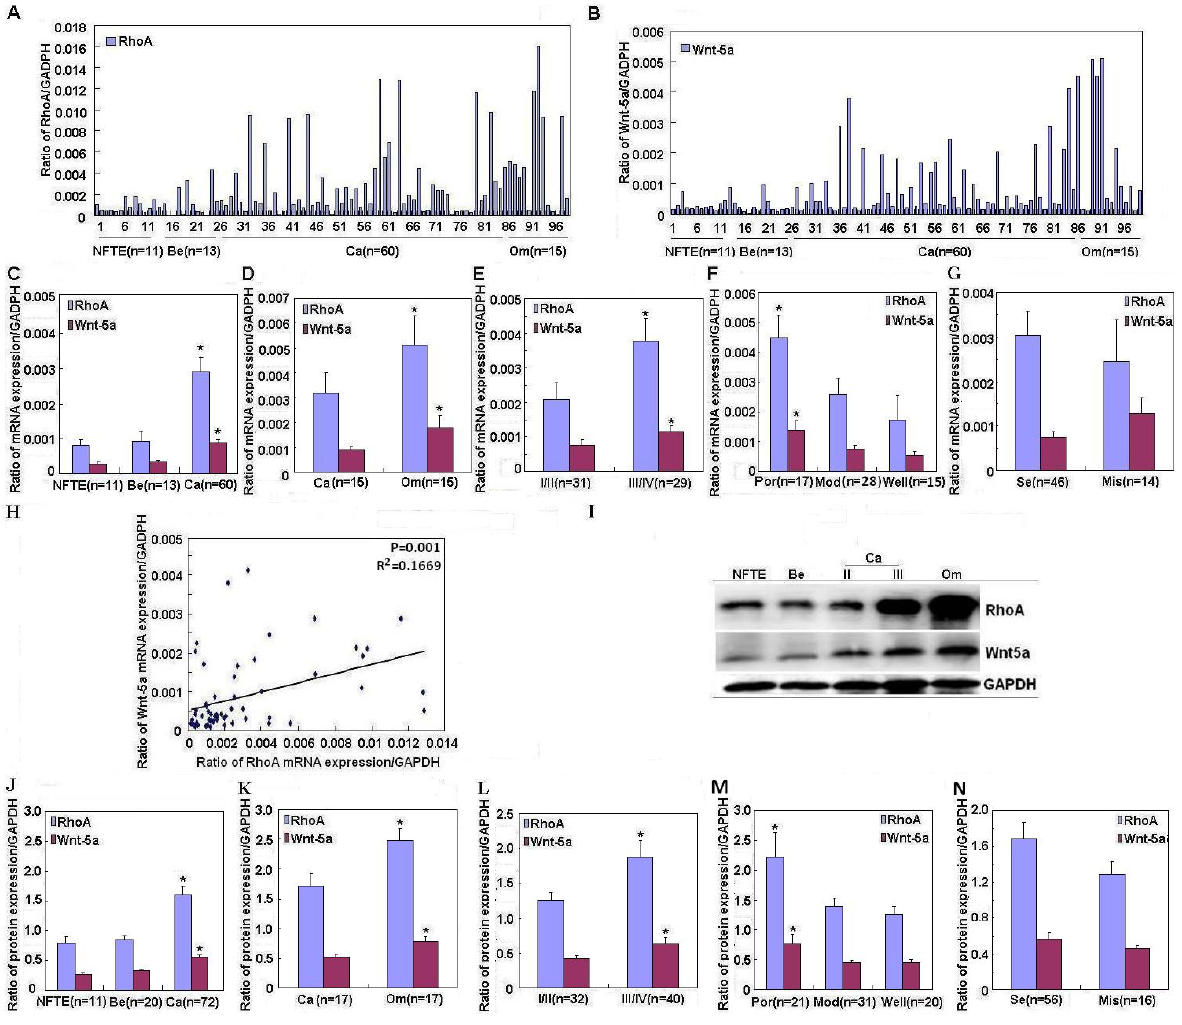
Figure 1. Correlation of RhoA and Wnt-5a mRNA and protein expression with the pathogenesis and aggressiveness of ovarian carcinoma. ( A – G , I – M ) RhoA and Wnt-5a mRNA and protein expression quantified in normal fallopian tube epithelium (NFTE), benign tumors (Be), primary ovarian carcinomas (Ca), and metastatic omentum (Om) using real-time PCR ( A , B ) and western blotting ( I ); Significantly higher RhoA and Wnt-5a mRNA and protein expression found in ovarian carcinomas compared to benign tumors or normal fallopian tube epithelium ( C , J ) and in metastatic omentum foci than in ovarian carcinomas ( D , K ); Positive association between RhoA and Wnt-5a mRNA and protein expression levels with FIGO staging ( E , L , stage I/II vs . stage III/IV) and degree of differentiation ( F , M , poorly differentiated (Por) vs . moderately differentiated (Mod) and well differentiated (Well)) in ovarian carcinoma; ( G , N ) No correlations between RhoA or Wnt-5a mRNA and protein expression and pathological subtype in ovarian carcinoma; and ( H ) Significant positive correlation between RhoA mRNA expression and Wnt-5a mRNA expression in ovarian carcinoma ( R 2 = 0.1669). * p <